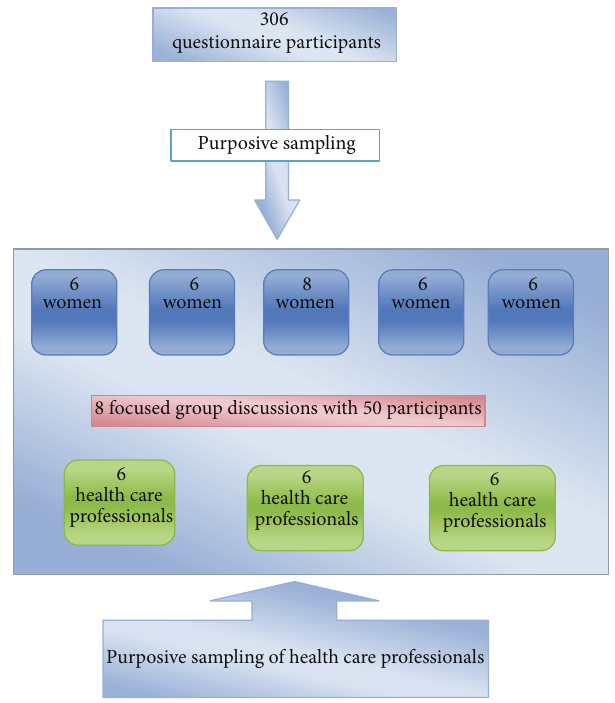
Figure 1: Scheme of recruitment of